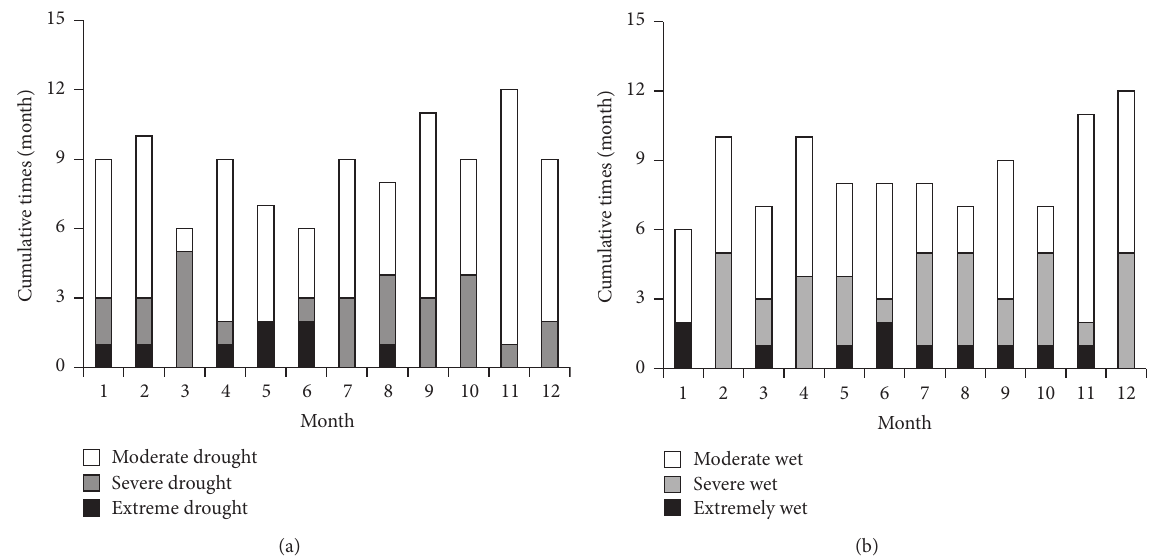
Figure 2: Monthly cumulative times of (a) dry and (b) wet episodes of different categories occurring in the Poyang Lake basin for the period 1960–2010.